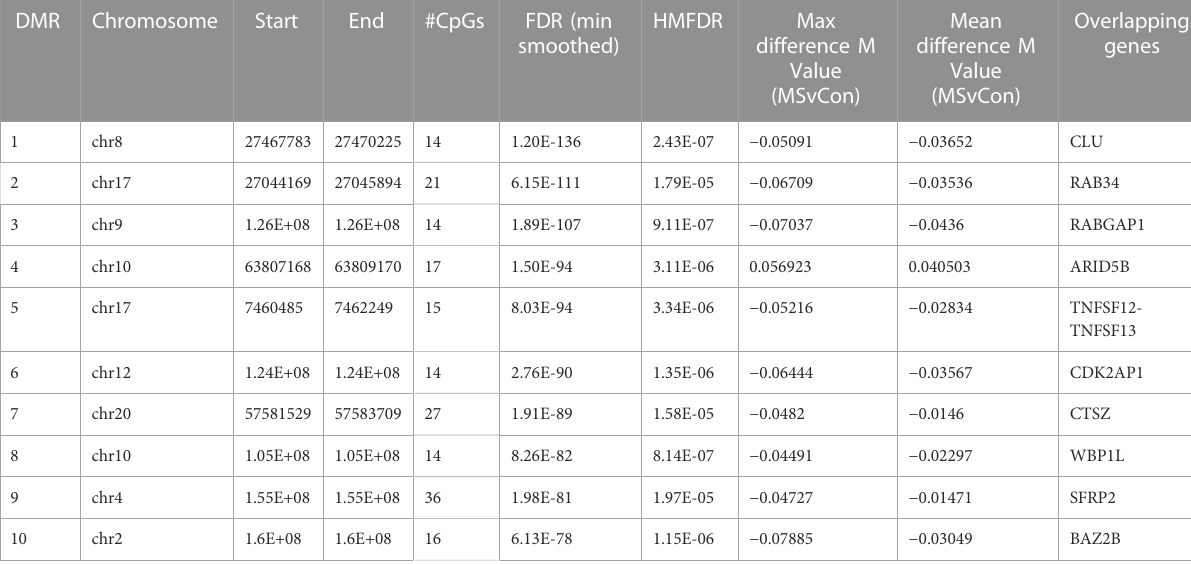
TABLE 5 Top 10 differentially methylated regions (DMR) associated with multiple sclerosis.